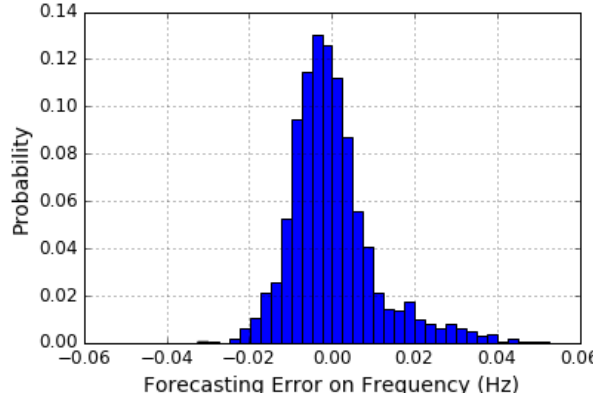
Figure 11. Distribution of f min forecasting errors without preventive controls.